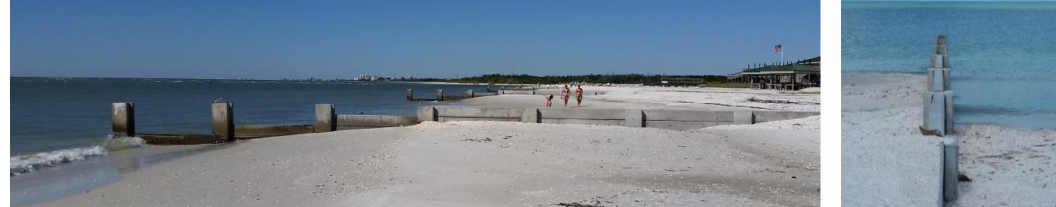
Figure 2. Photos of the king ‐ pile groins on Big Hickory Island, FL.